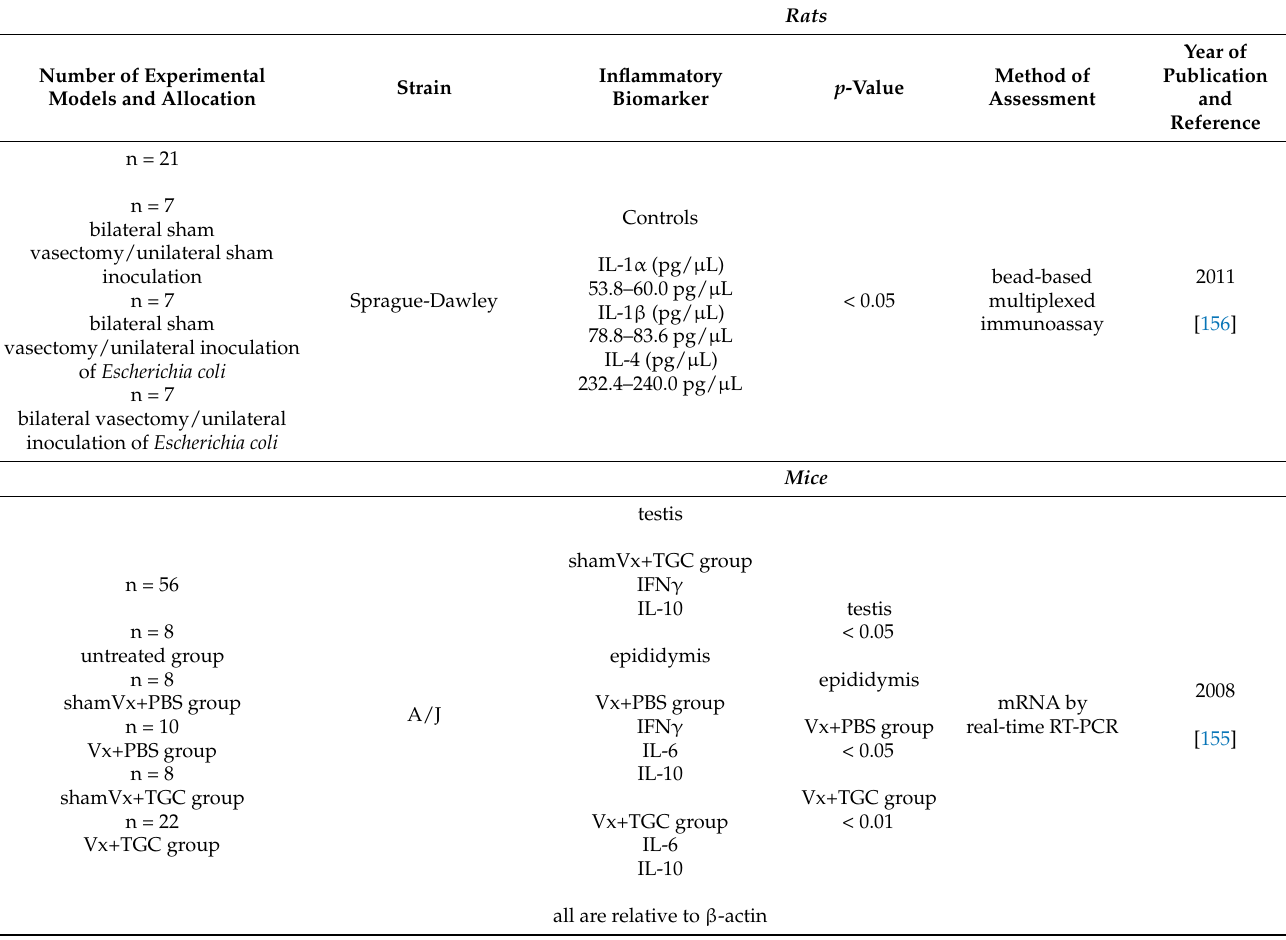
Table 4. Stratification of studies per year of publication based on design, allocation, and strain with the main results that highlight inflammation in rats and